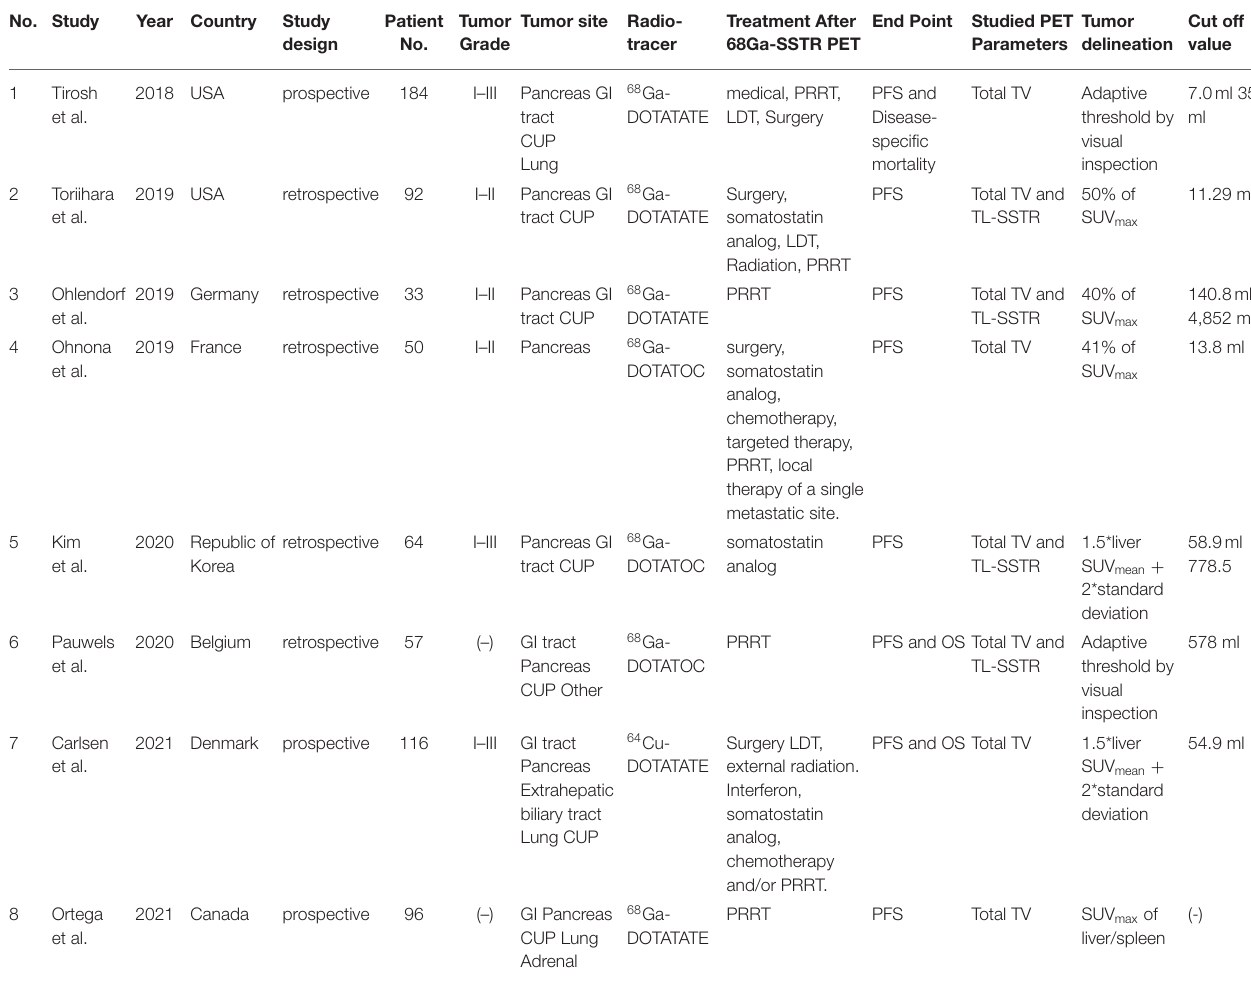
TABLE 1 | Characteristics of the included